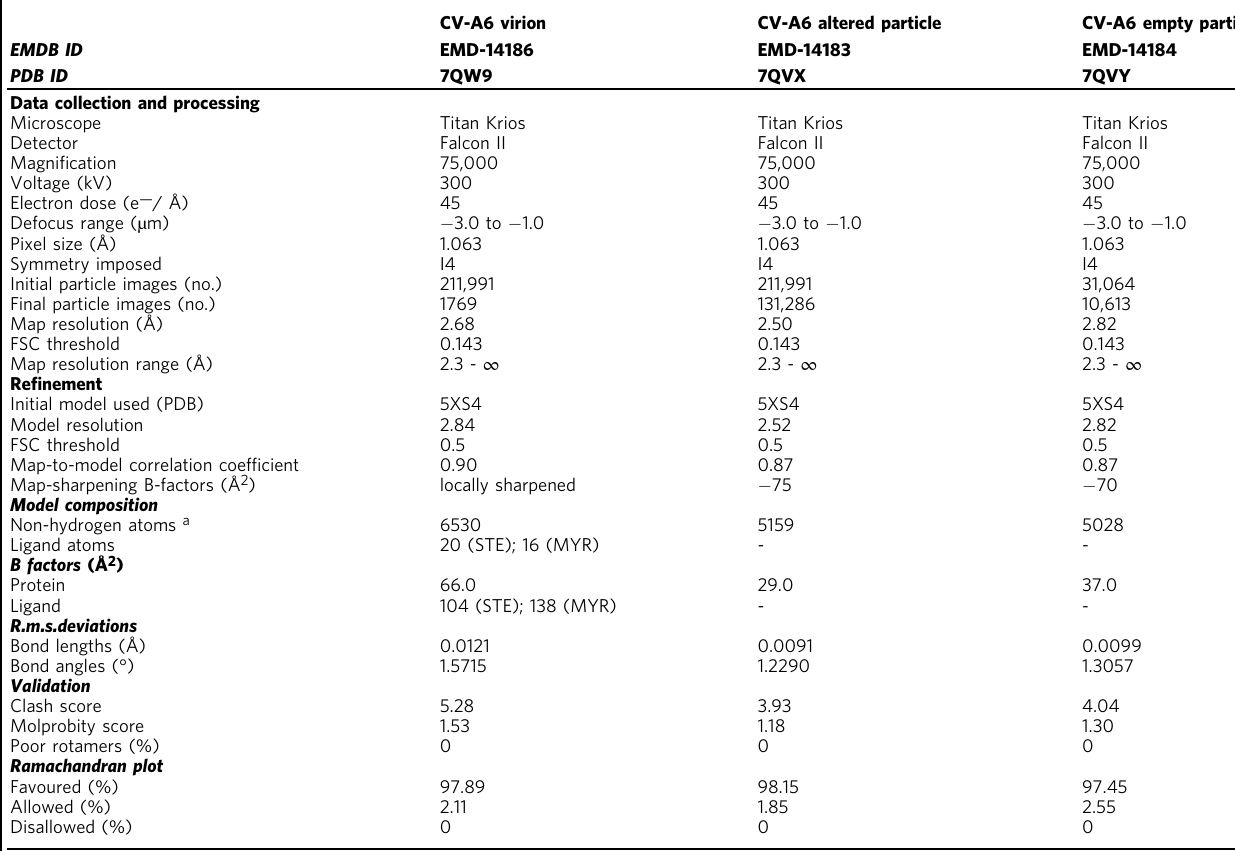
Table 1 Cryo-EM data collection, re fi nement and validation